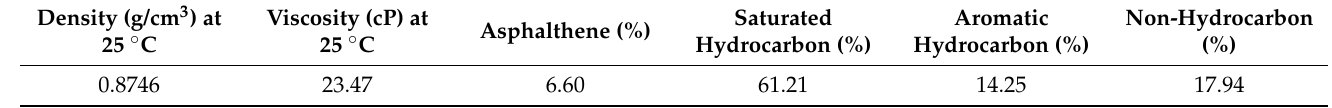
Table 2. Physical and chemical properties of crude